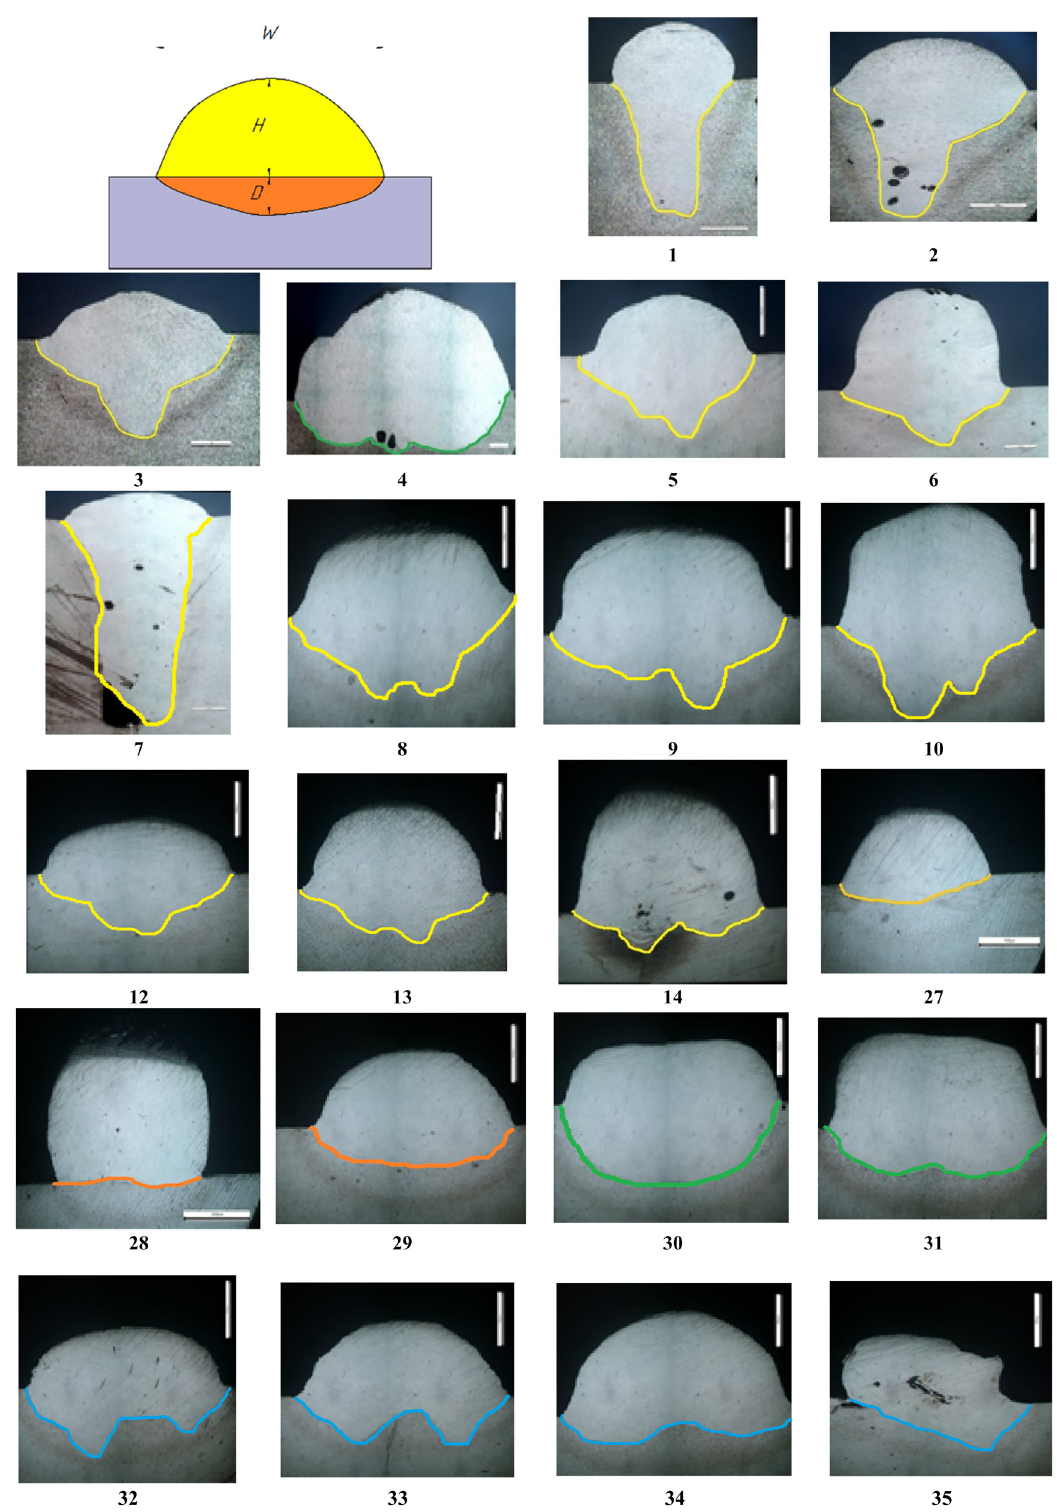
Figure 5. Macrostructure of samples No.